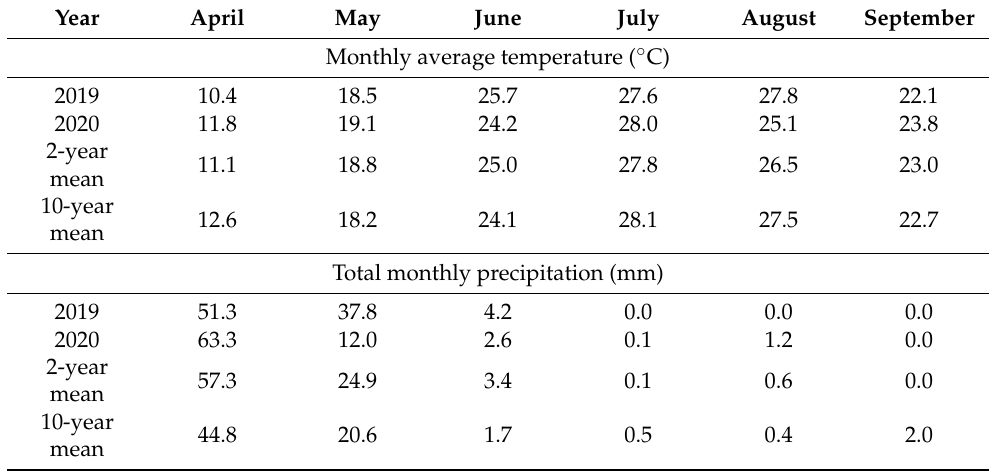
Figure 7. Aerial view of the experimental area (longitude 46°16 ′ E, latitude 37°22 ′ N, altitude 1532 m). The experimental area is shown by green mark. Table 5. Monthly average temperature and total monthly precipitation in 2019 and 2020 growing seasons and long-term averages in the experimental area.